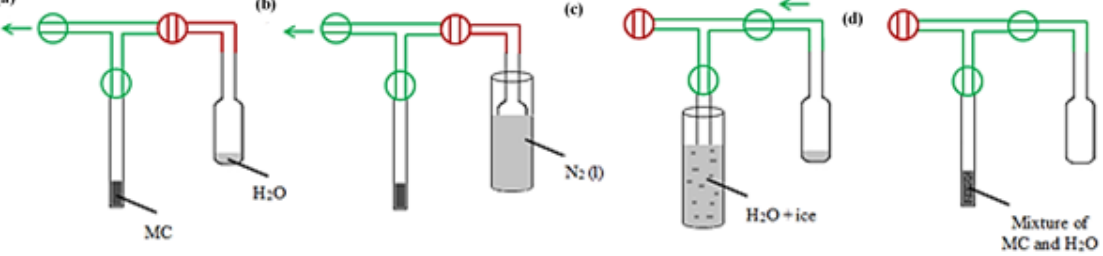
Figure 1. Scheme of preparation of MC sample for NMR analysis: ( a ) evacuation of the dry sample, ( b ) freezing the reservoir with water, ( c ) sublimation of water to sample, ( d ) final prepared sample.